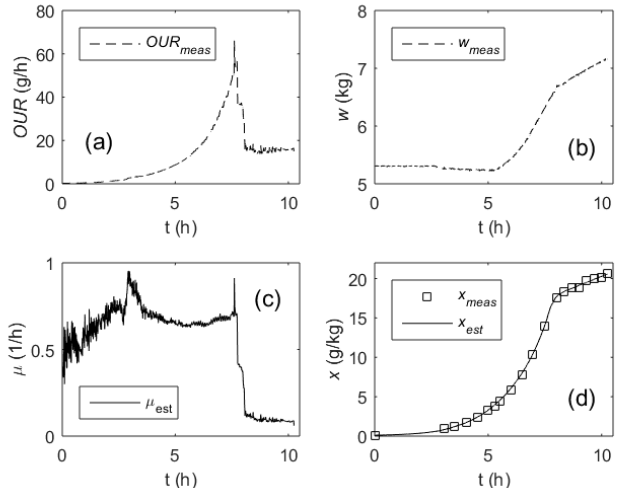
Figure 5. Performance of the specific growth rate estimator in a fed-batch process: Oxygen uptake rate, OUR ( a ); culture broth weight, w ( b ); specific growth rate, µ ( c ); biomass concentration, x ( d ) (dashed lines—measured online, solid lines—estimated online, squares—measured off-line).